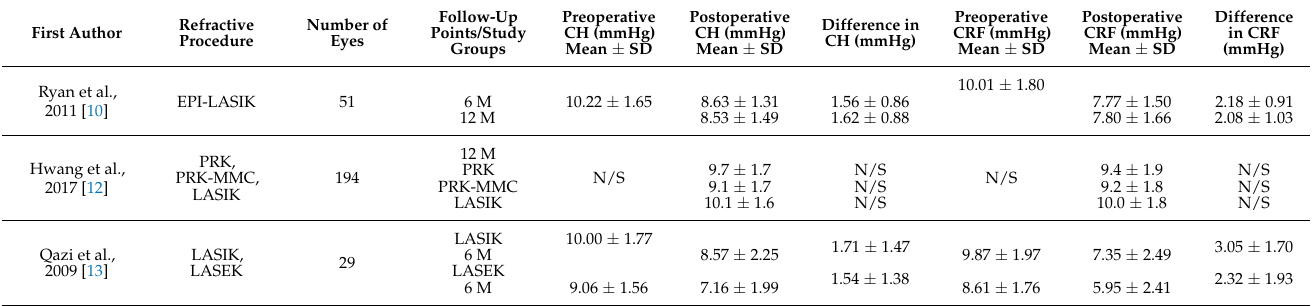
Table 2. Characteristics of corneal biomechanical parameters assessed by